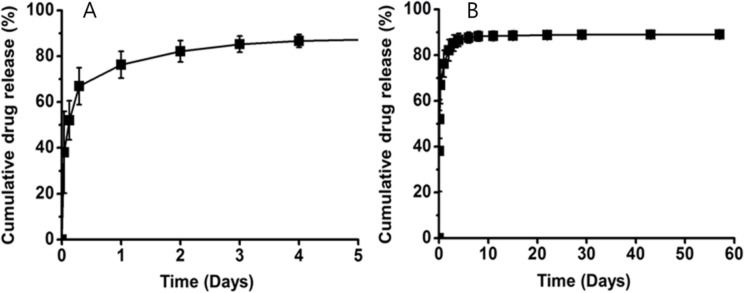
Curves show in vitro release profiles of EW-7197 from nanofiber membrane at (A) 5 days and (B) 60 days. Error bars = standard deviation of mean (n = 6).